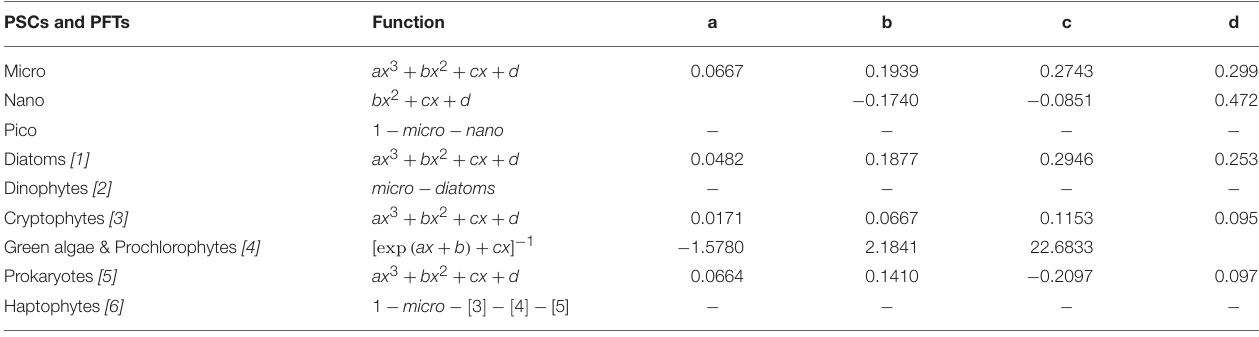
TABLE 4 | Regional algorithms developed to estimate the PSCs and PFTs in the Mediterranean Sea (as fraction of TChl a , ranging from 0 to 1). For each dimensional and functional group, the equation and its relative coefficients are given. PSCs and PFTs